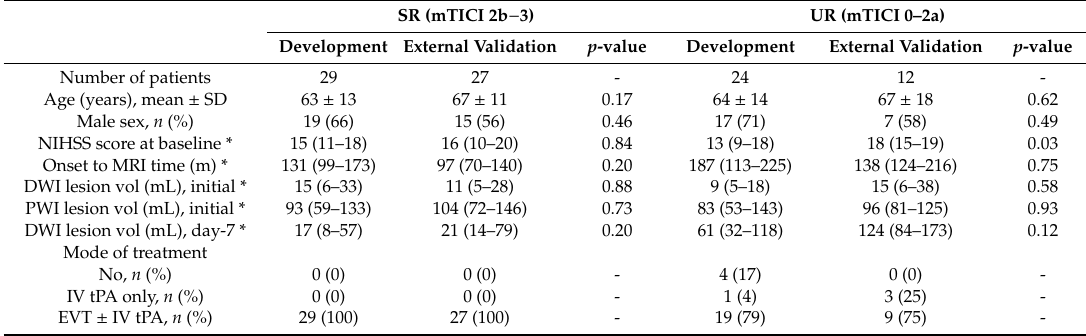
Table 1. Patient characteristics for machine learning (ML) model development and external